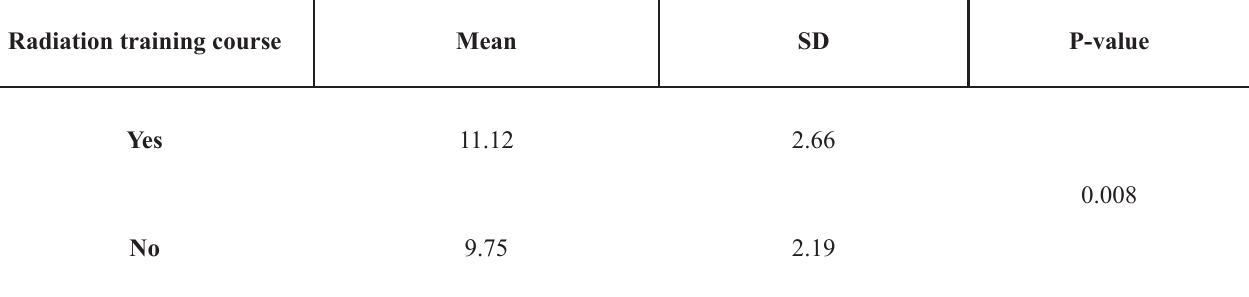
Table 6. Scores of knowledge of medical staff about the principles of radiation protection in terms of radiation training